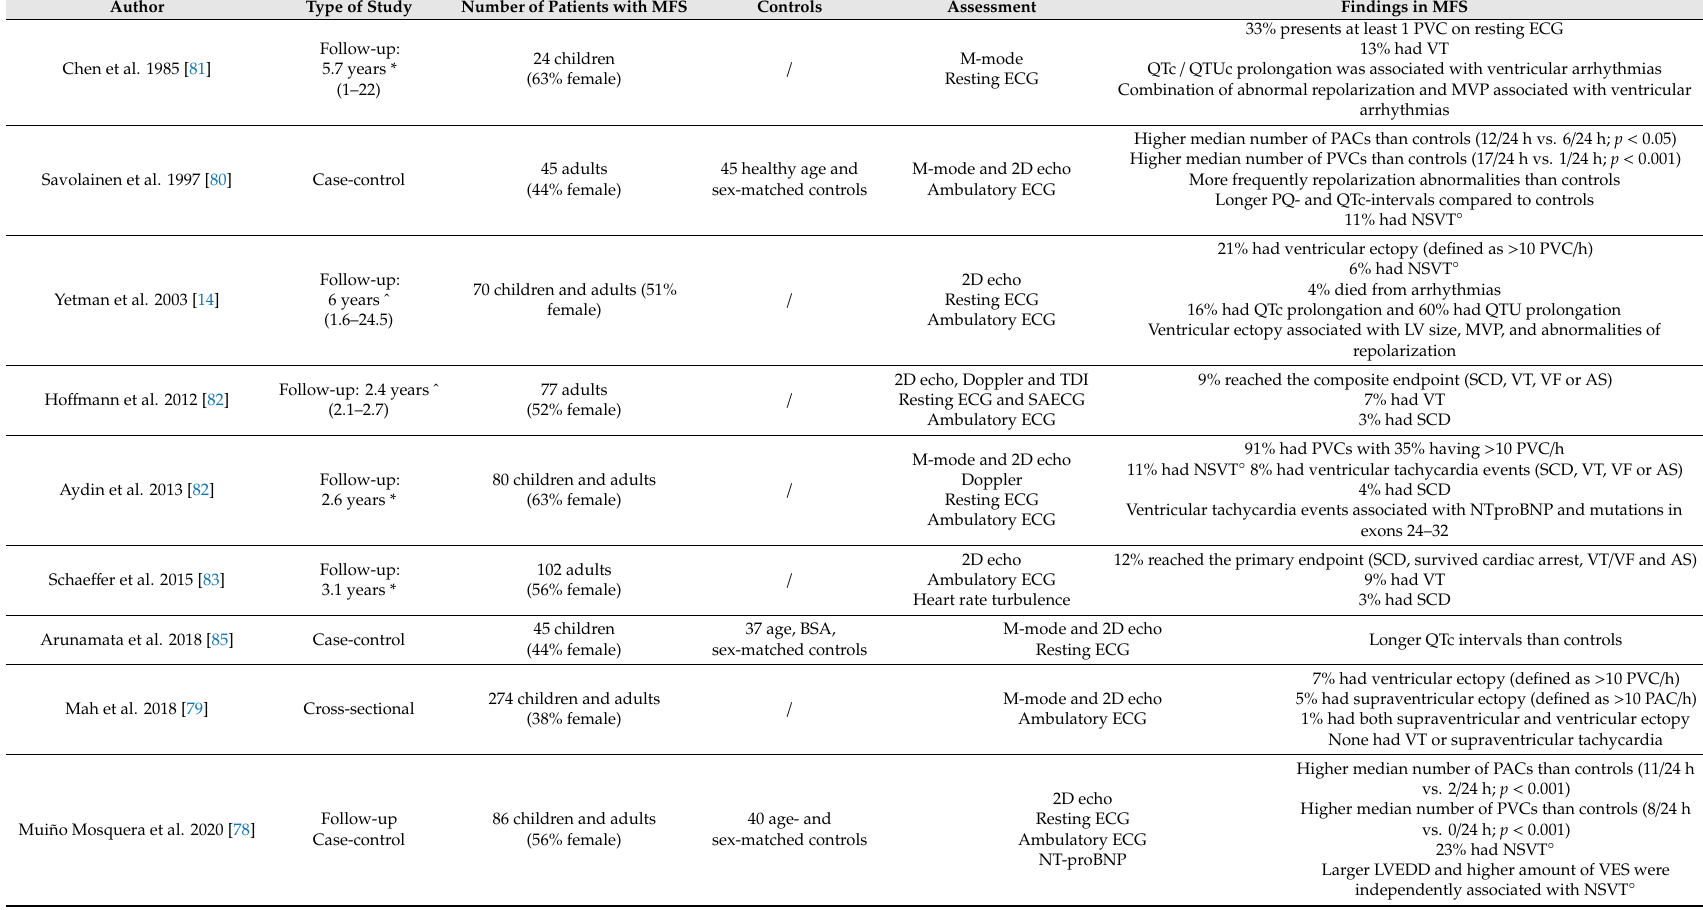
Table 4. Summary of studies assessing arrhythmia in